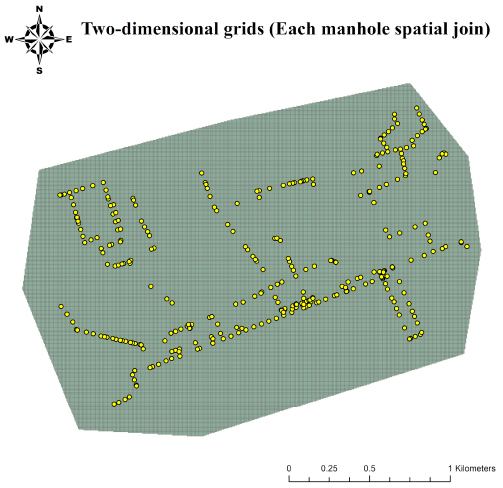
Figure 6. The exact location of each manhole was adjusted by the ArcGIS model.